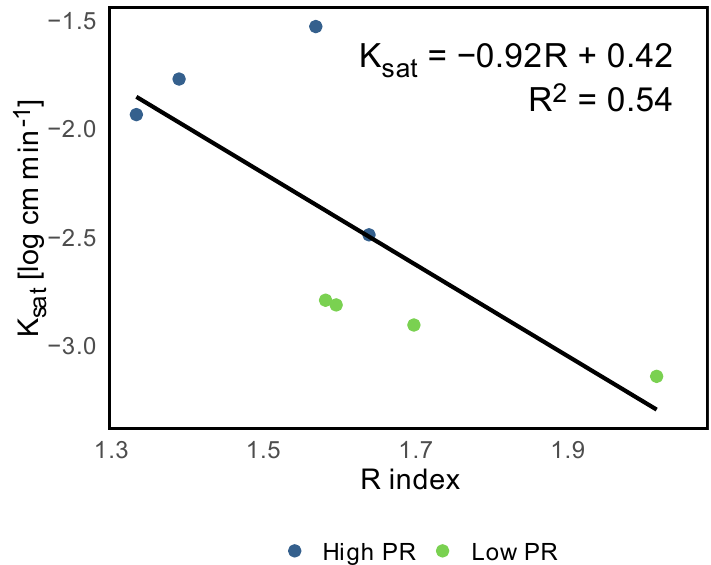
Figure 7. Hydraulic conductivity (Log K) as a function of the repellency index (R).